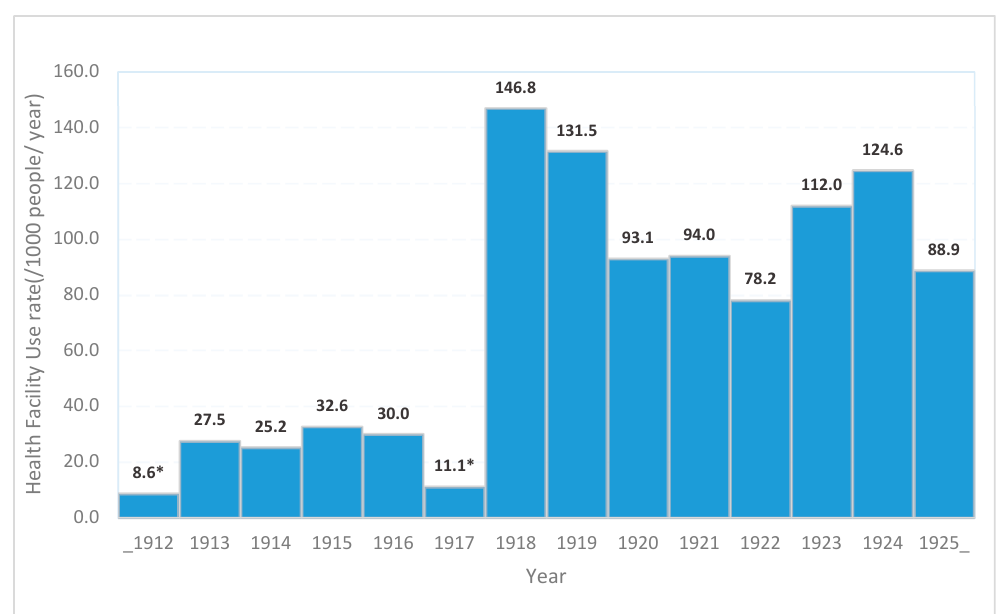
Figure 3. Health facility use rates of Coast Province Kenya, 1912–1925. * Missing data, only Mombasa data reported. Lamu and Tana River districts data missing for years 1917, 1918, 1919 and 1921.